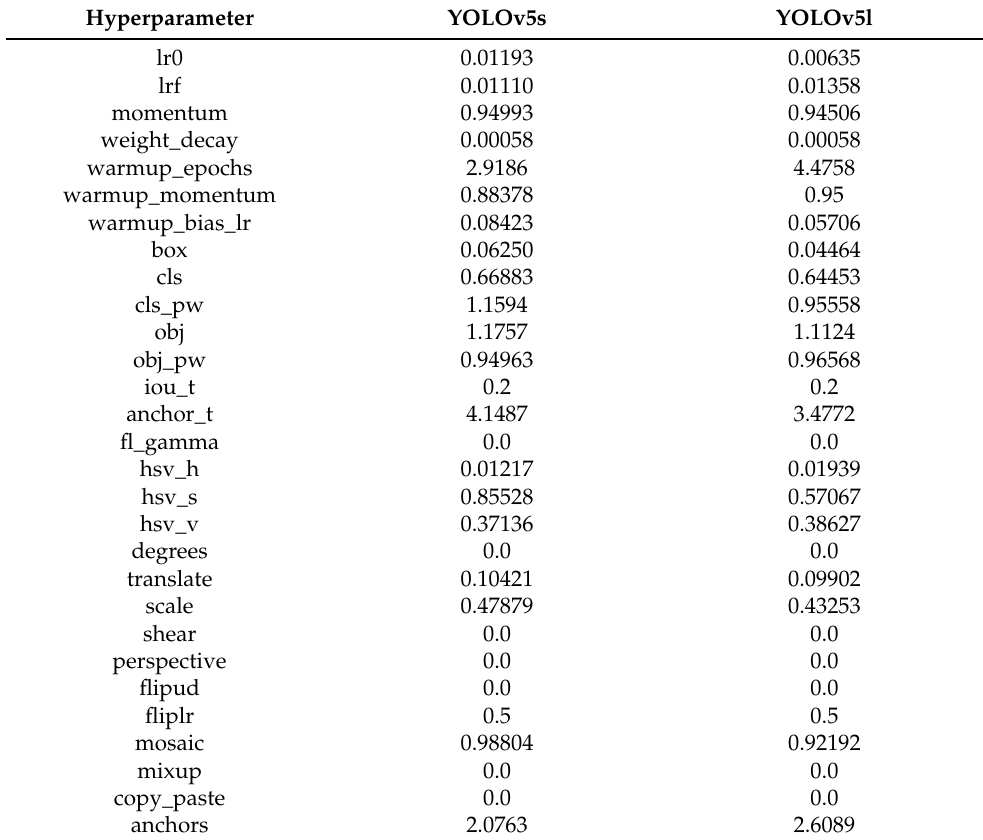
Table 1. Optimised hyperparameters after evolving for YOLOv5s and YOLOv5l.